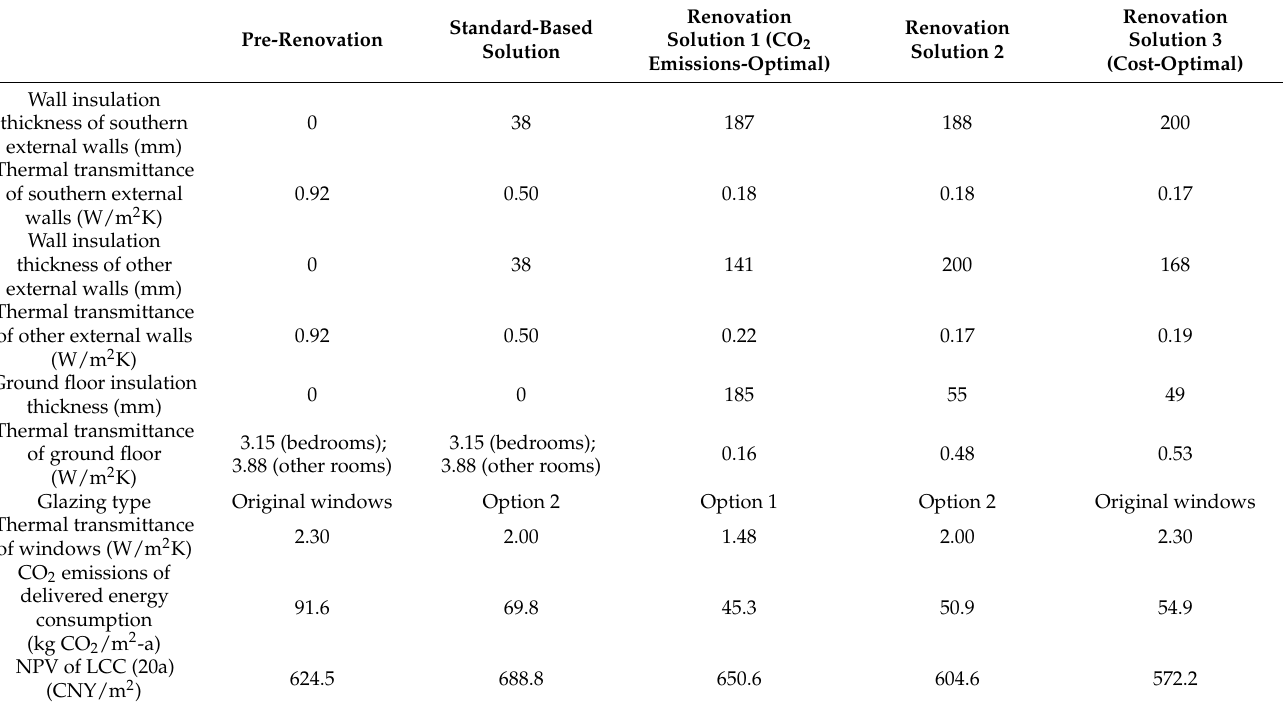
Table 6. Comparison of pre-renovation cases and renovation solutions under continuous heating